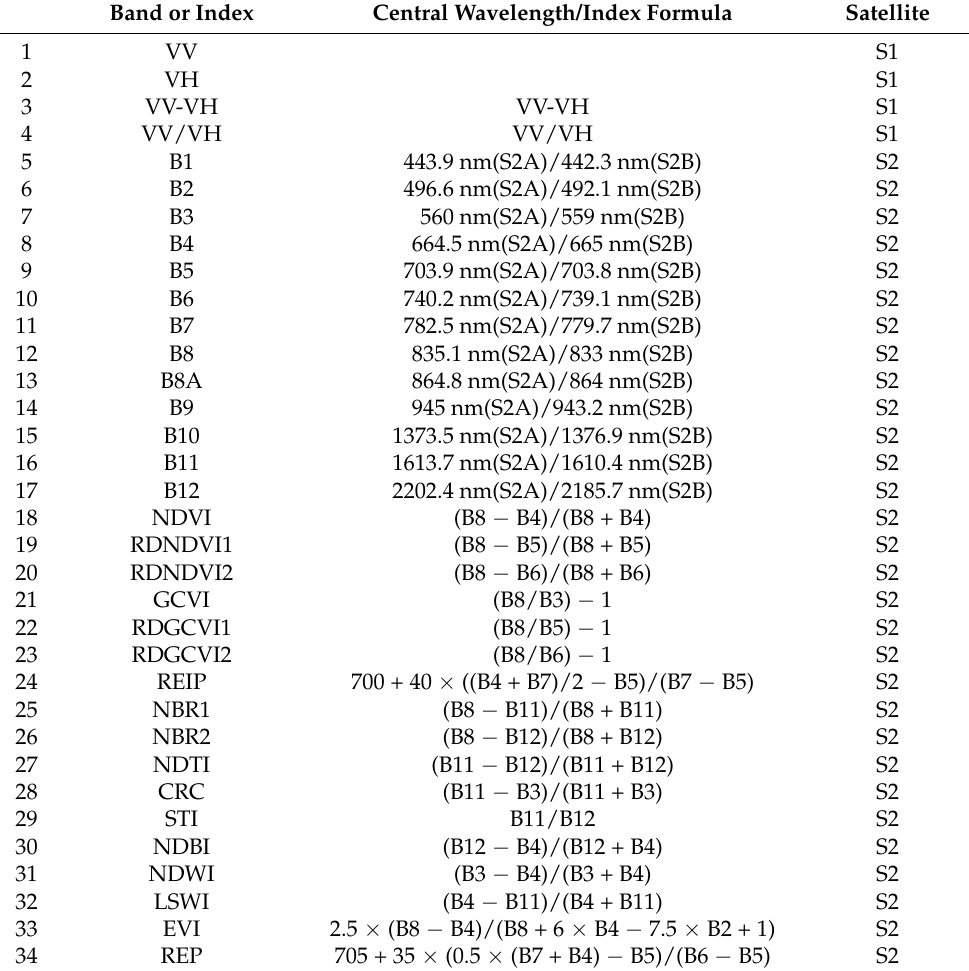
Table 1. Bands and spectral indicators form Sentinel 1 and Sentinel 2